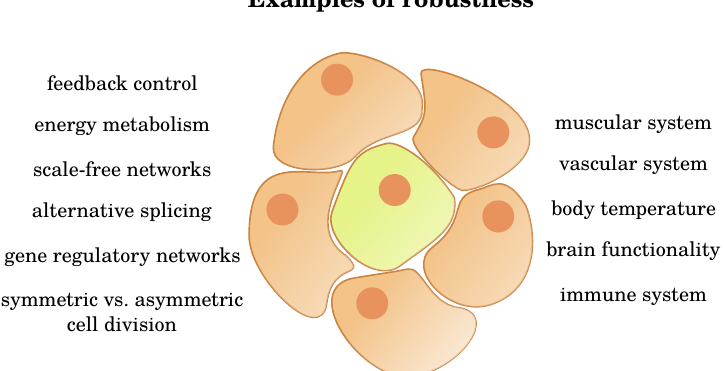
Figure 4. Examples of robustness discussed throughout this review. Some of the observed mechanisms apply to the cellular as well as the organ levels (left), others only to organ level